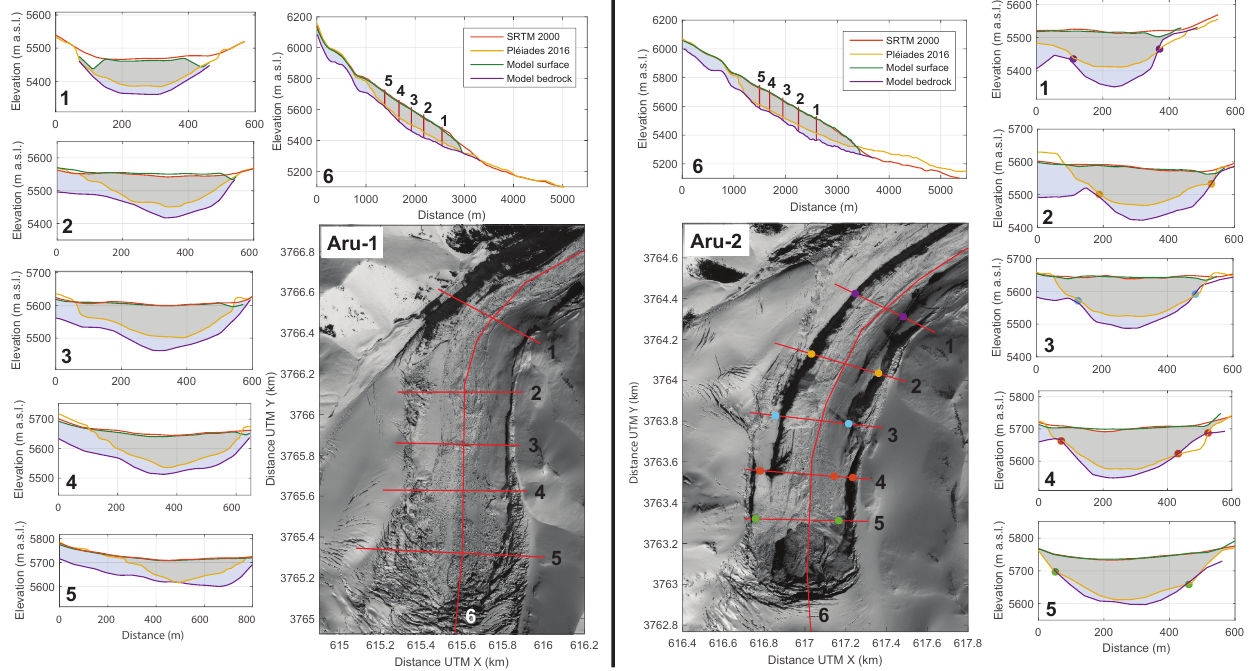
Figure 3. Pléiades image of Aru-1 (left) and Aru-2 (right) glaciers after collapse, with topographic profiles 1 to 6 plotted for both glaciers (Copyright CNES 2016, Distribution Airbus D&S). The topographic profiles 1 to 6 show the measured surface topography in 2000 (SRTM, in red) and 2016 after the collapse (Pléiades, in yellow). These profiles are compared with the modelled bedrock (in purple) and surface (in green) topographies. The coloured dots on the Aru-2 glacier show the location of specific points of the profiles in the Pléiades image. Those points correspond to locations where our reconstruction matches the Pléiades DEM and where bedrock should thus be visible on the Pléiades image (no ice debris). Grey shading indicates the detached parts according to the Pléiades DEM compared to